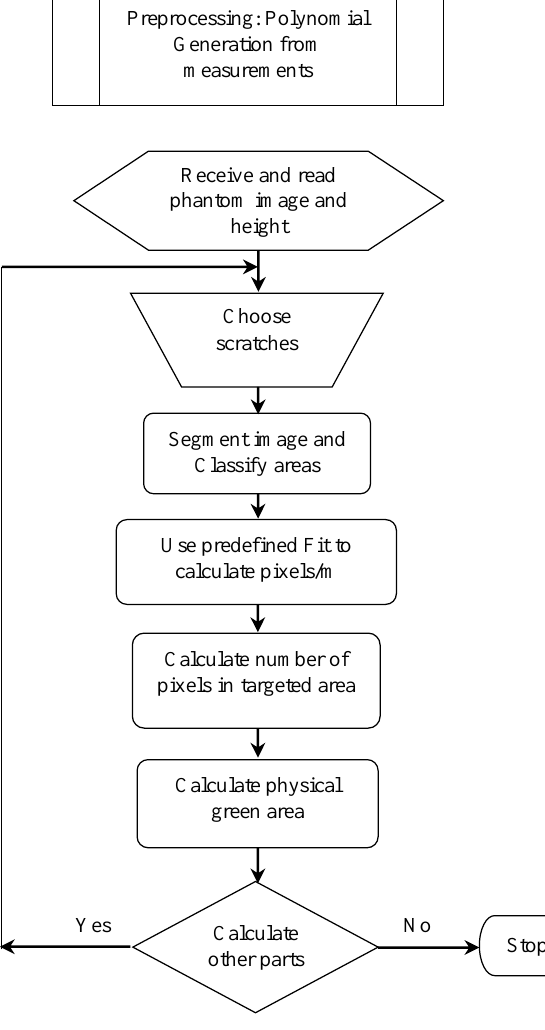
Figure 7. Image classification and area calculation algorithm distance sensor, with images fed into a computer program. Google earth images are not appropriate for such processing, since small area classifications and calculations requires high resolution images at low